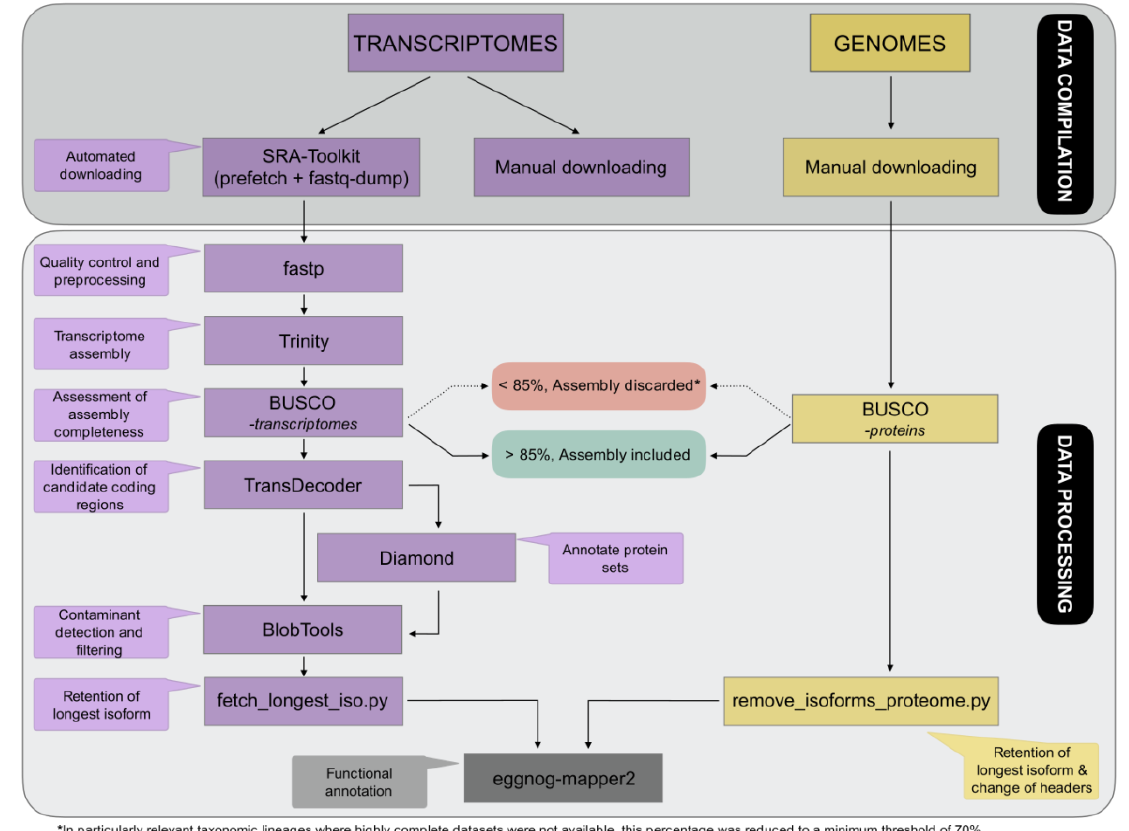
Figure 2. Pipeline followed to generate the MATEdb database. All steps are discussed in detail